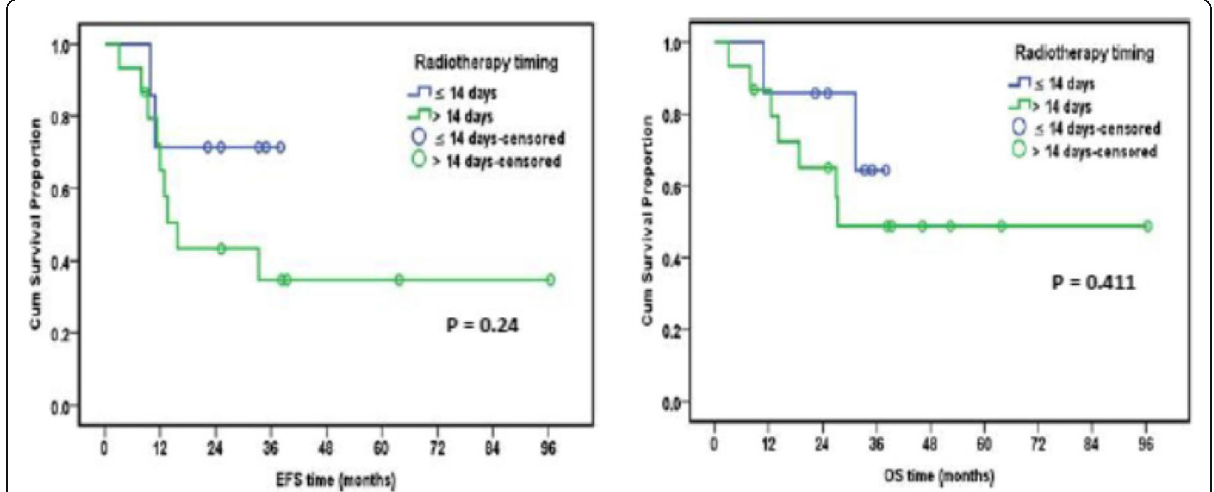
Fig. 7 Event-free and overall survival by surgery radiotherapy